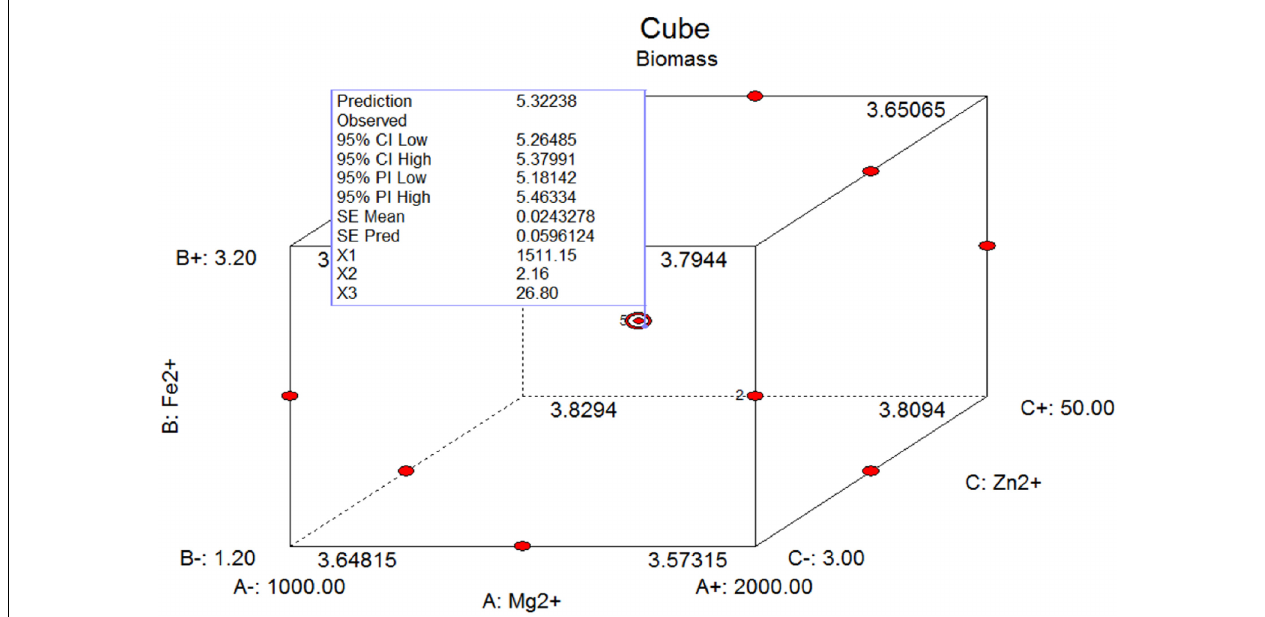
FIGURE 1 | The integrative effect of metal ions (Mg 2 + , Fe 2 + , and Zn 2 + ) on biomass based on RSM analysis.